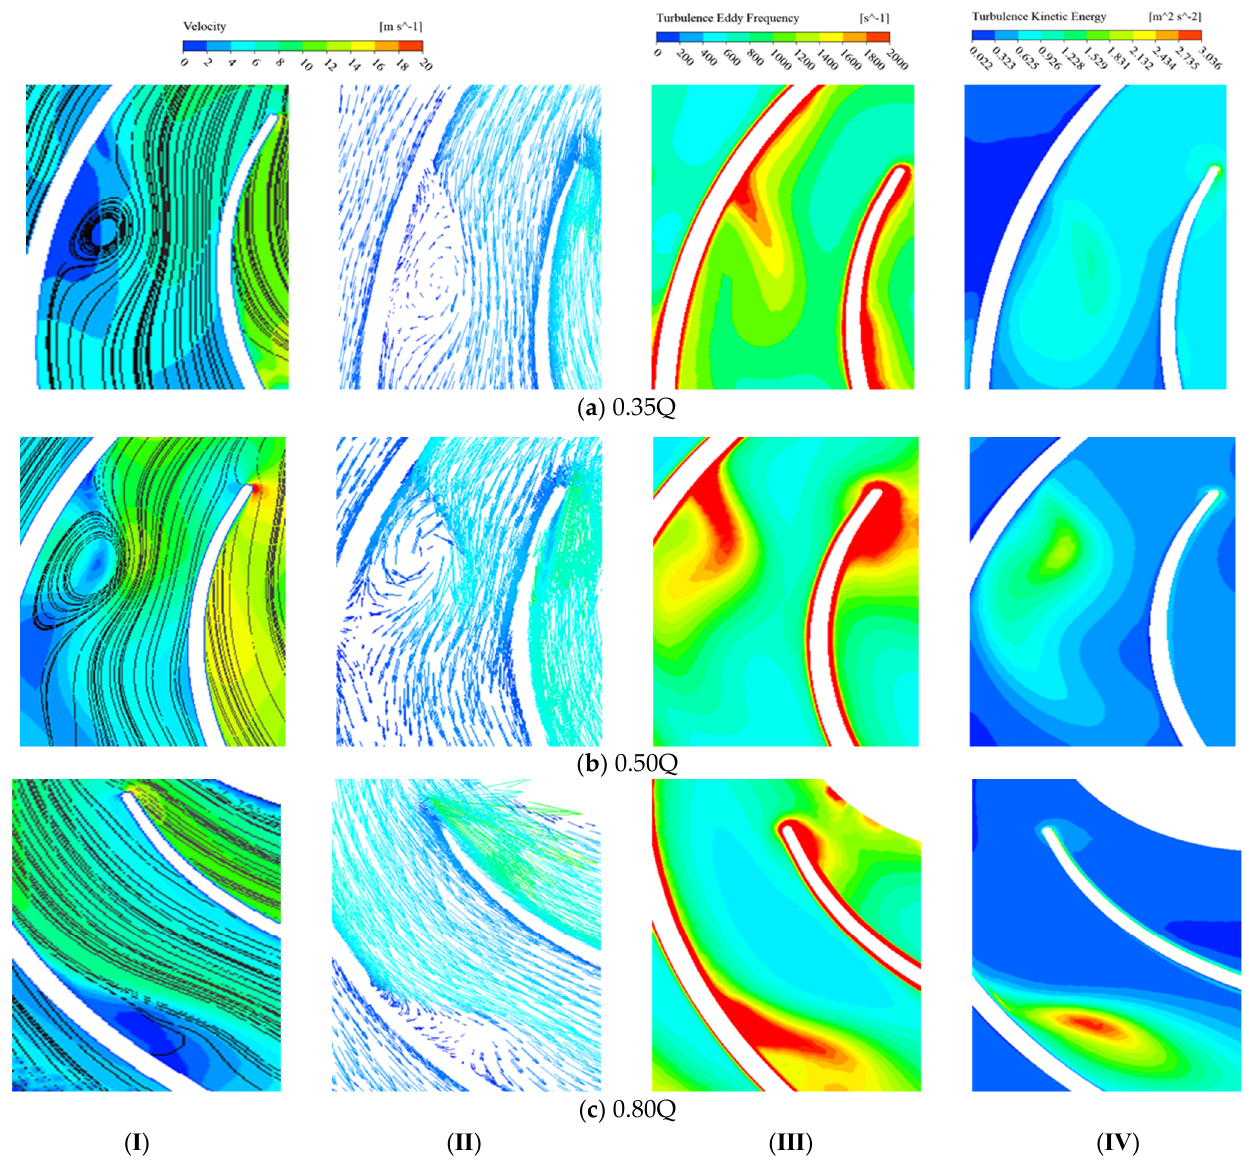
Figure 10. View of internal flow of scheme A. ( Ⅰ ) Streamline, ( Ⅱ ) Relative velocity vector, ( Ⅲ ) Turbulence vortex frequency and ( Ⅳ ) Turbulence kinetic energy.